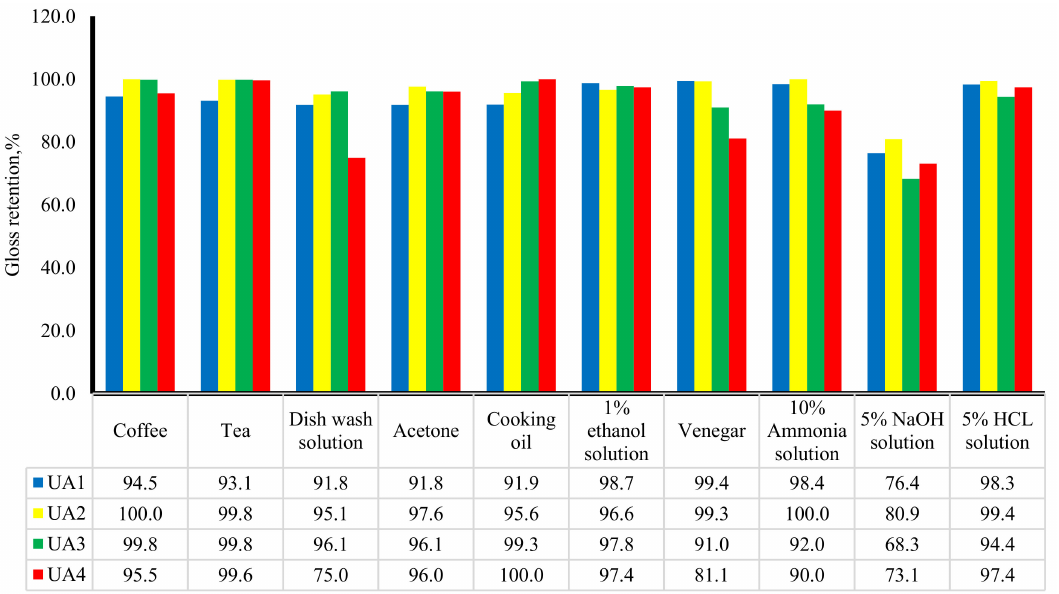
Figure 9. Gloss retention, after 24 h chemical